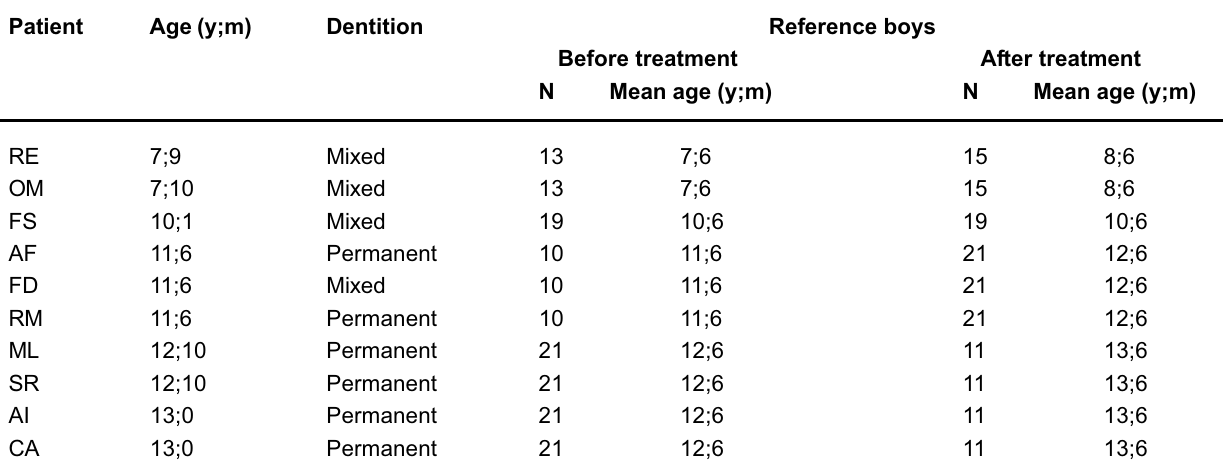
TABLE 1- Orthodontic patients and reference subjects evaluated in the